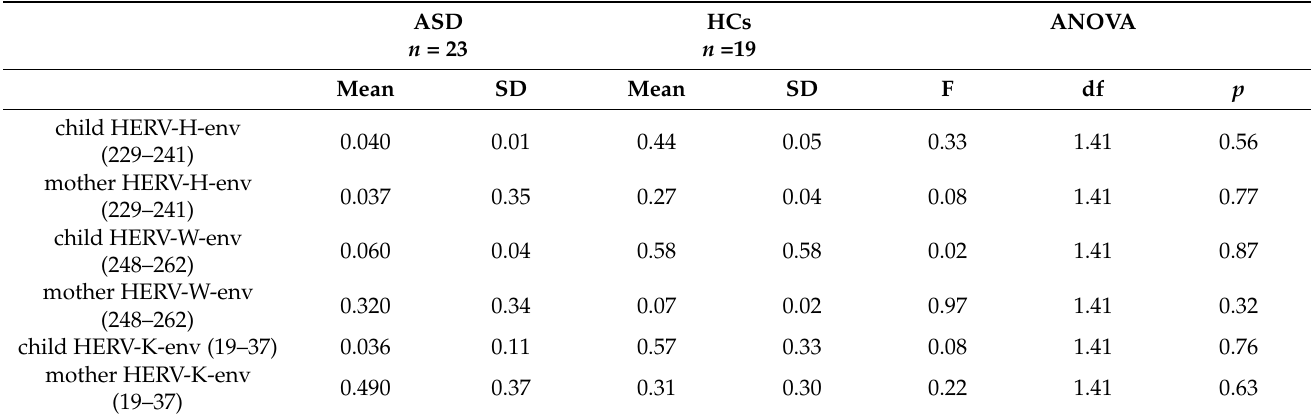
Table 7. ANOVA group comparisons of anti-HERV-env levels between mothers and children of both groups.